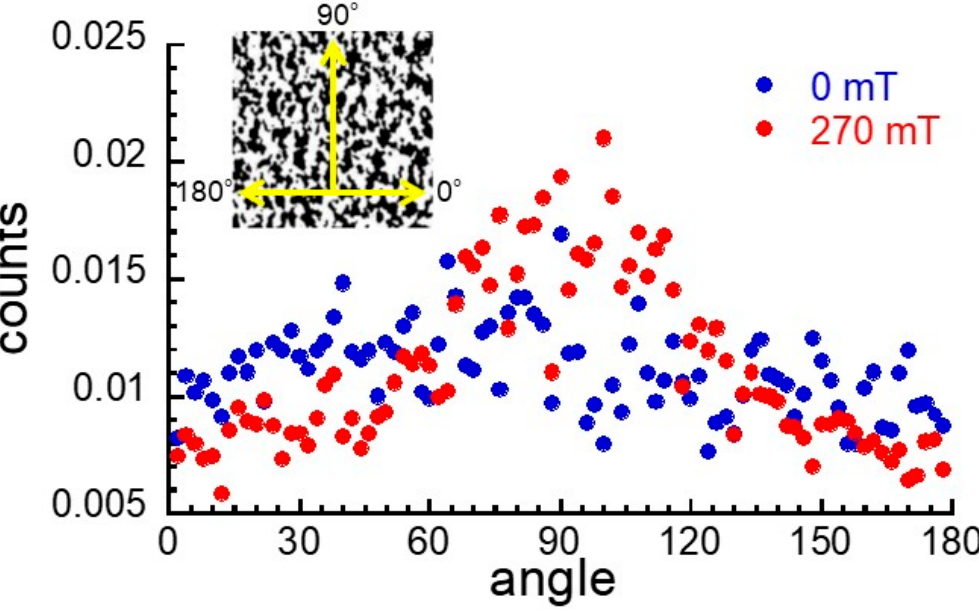
Figure 6. Angle distribution for magnetic elastomers at 0 (left) and 270 mT (right) (CI 70 wt%, DOP 70 wt%).